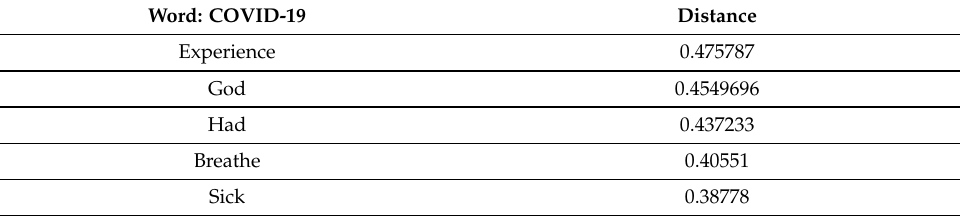
Table 3. Closest words of COVID-19.